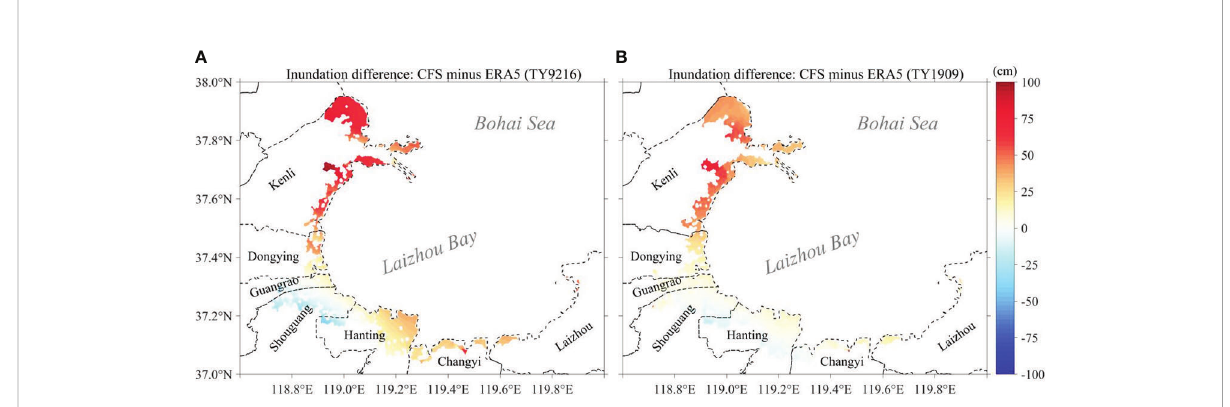
FIGURE 8 The inundation depth difference (cm) distributions between CFS- (Exp2) and ERA5-based (Exp4) simulations along the LZB during TY9216 (A) and TY1909 (B) .